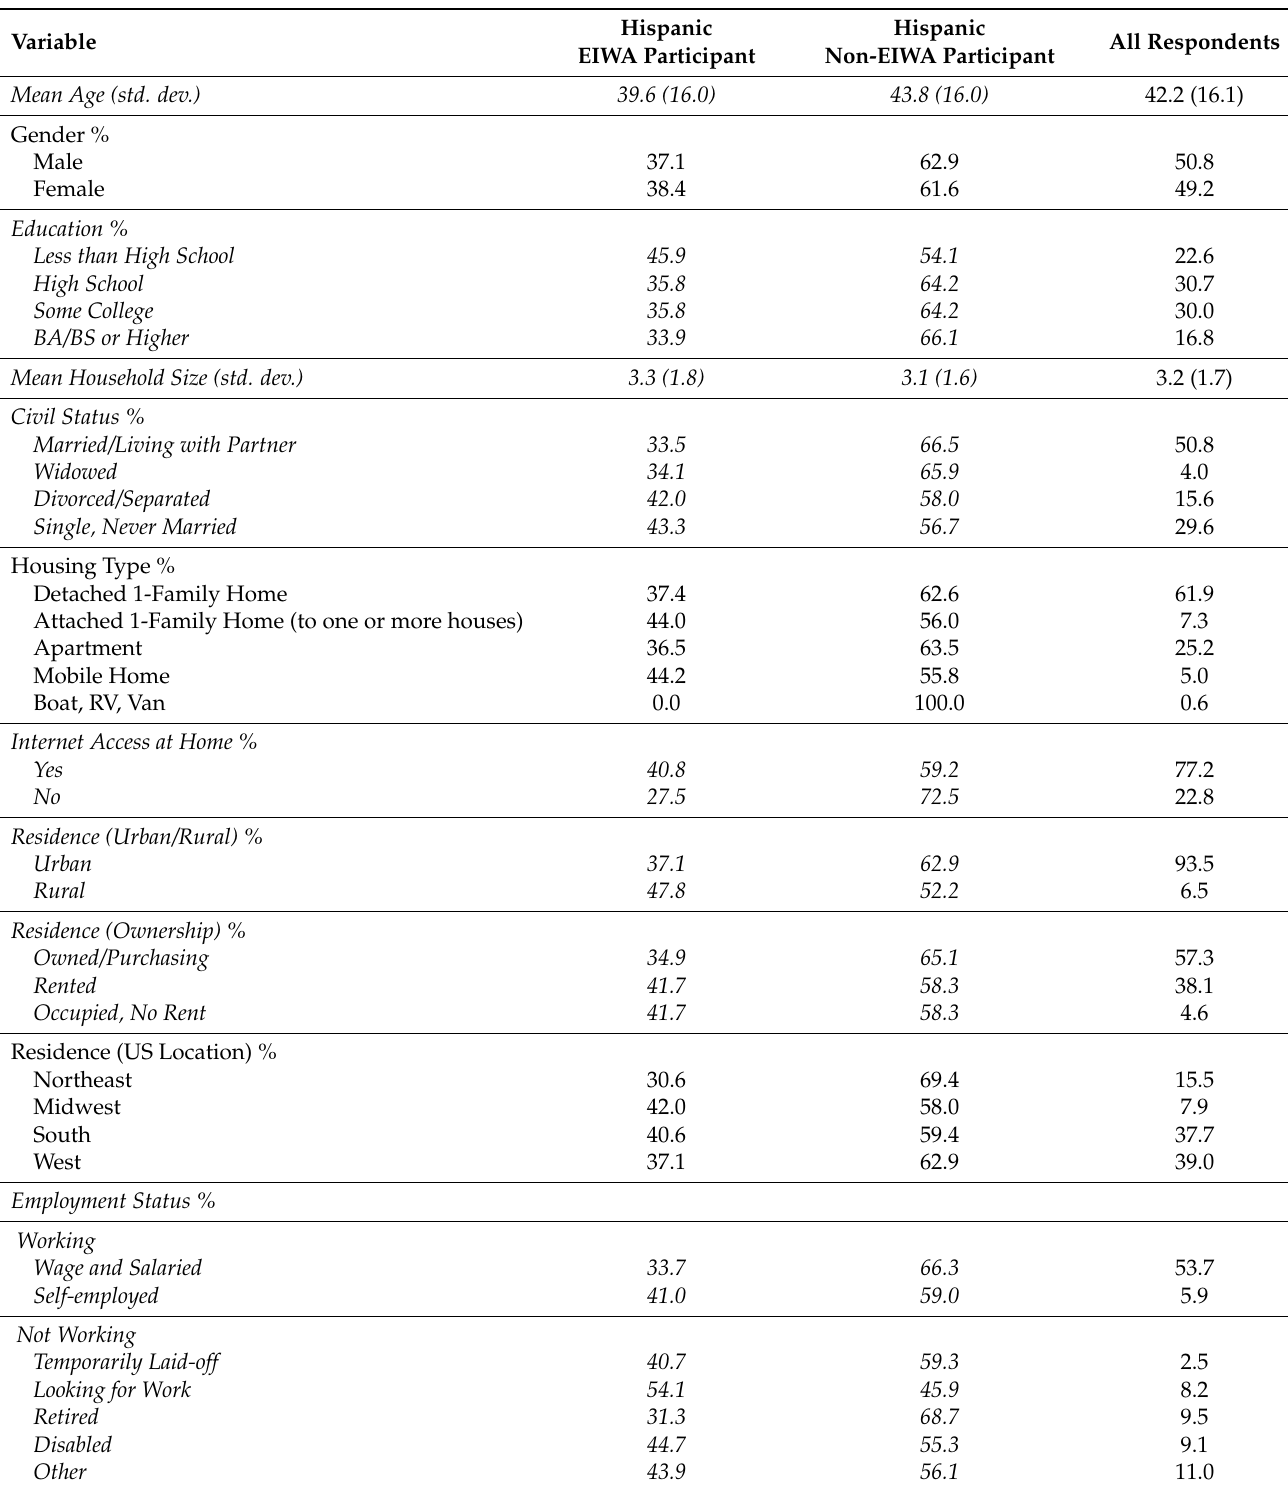
Table 3. EIWA Demographic Statistics for Hispanics and All